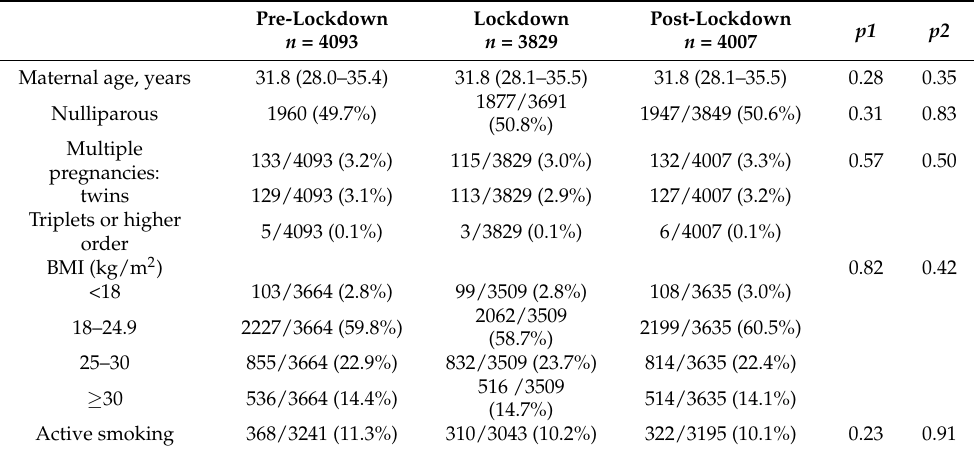
Table 1. Comparison of maternal and pregnancy characteristics between the three periods.